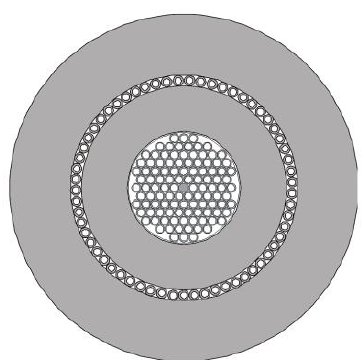
Figure 7. Design of the preform structure.